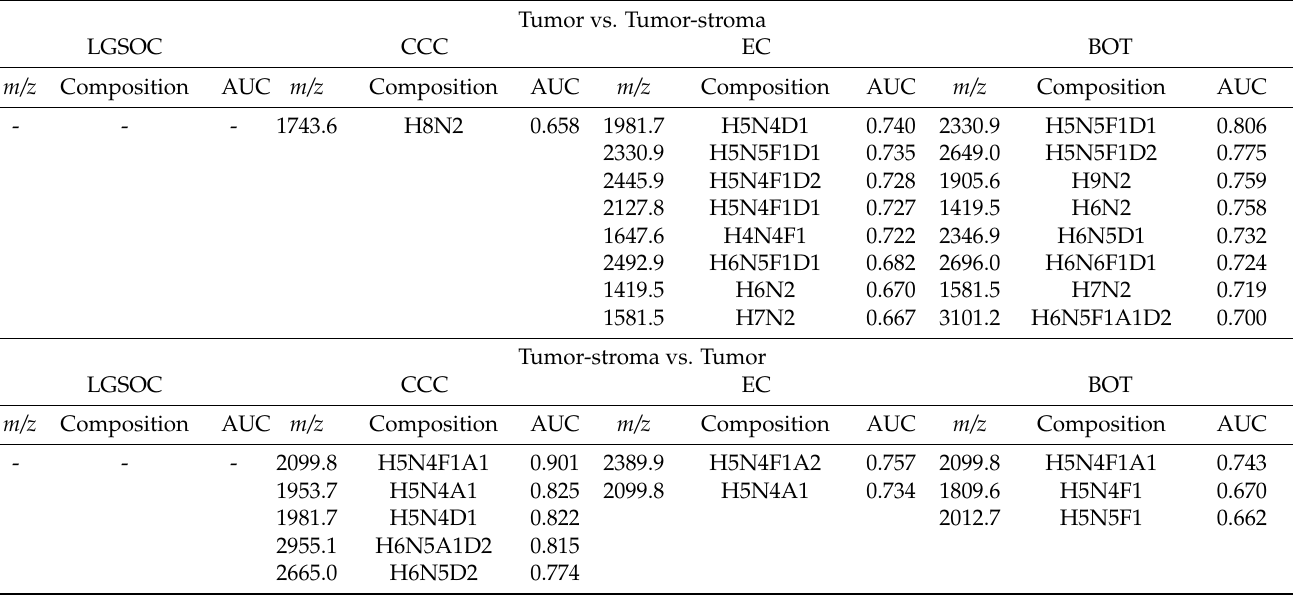
Table 2. The most discriminative N -glycan structures as determined by ROC curve analyses of tumor vs. tumor-stroma and tumor-stroma vs. tumor regions in LGSOC ( n = 4), CCC ( n = 6), EC ( n = 7), and BOT ( n = 7) tissue